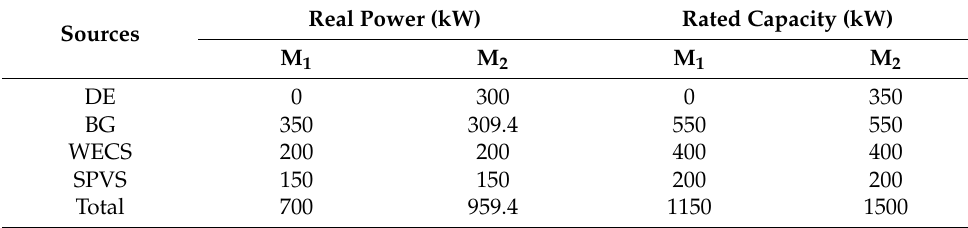
Table 1. Steady-state generation values for both microgrids.